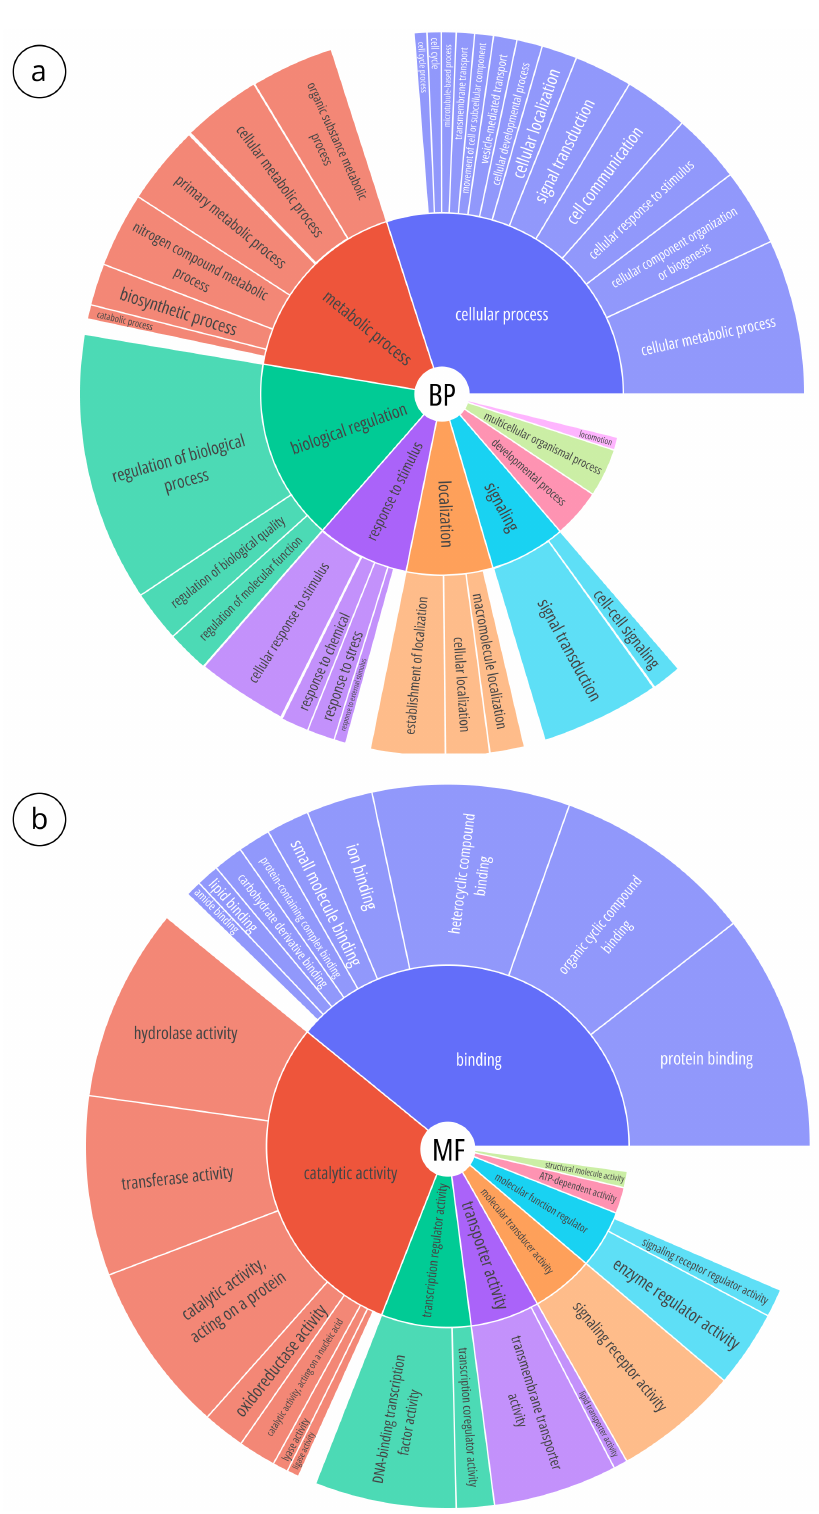
Figure A1. Functional classification of genes, according to Gene Ontology terms from EggNOG- mapper annotation of Darevskia valentini . ( a )—Biological process, ( b )—Molecular function. For better visibility, sparsely represented terms (<100 genes) are not